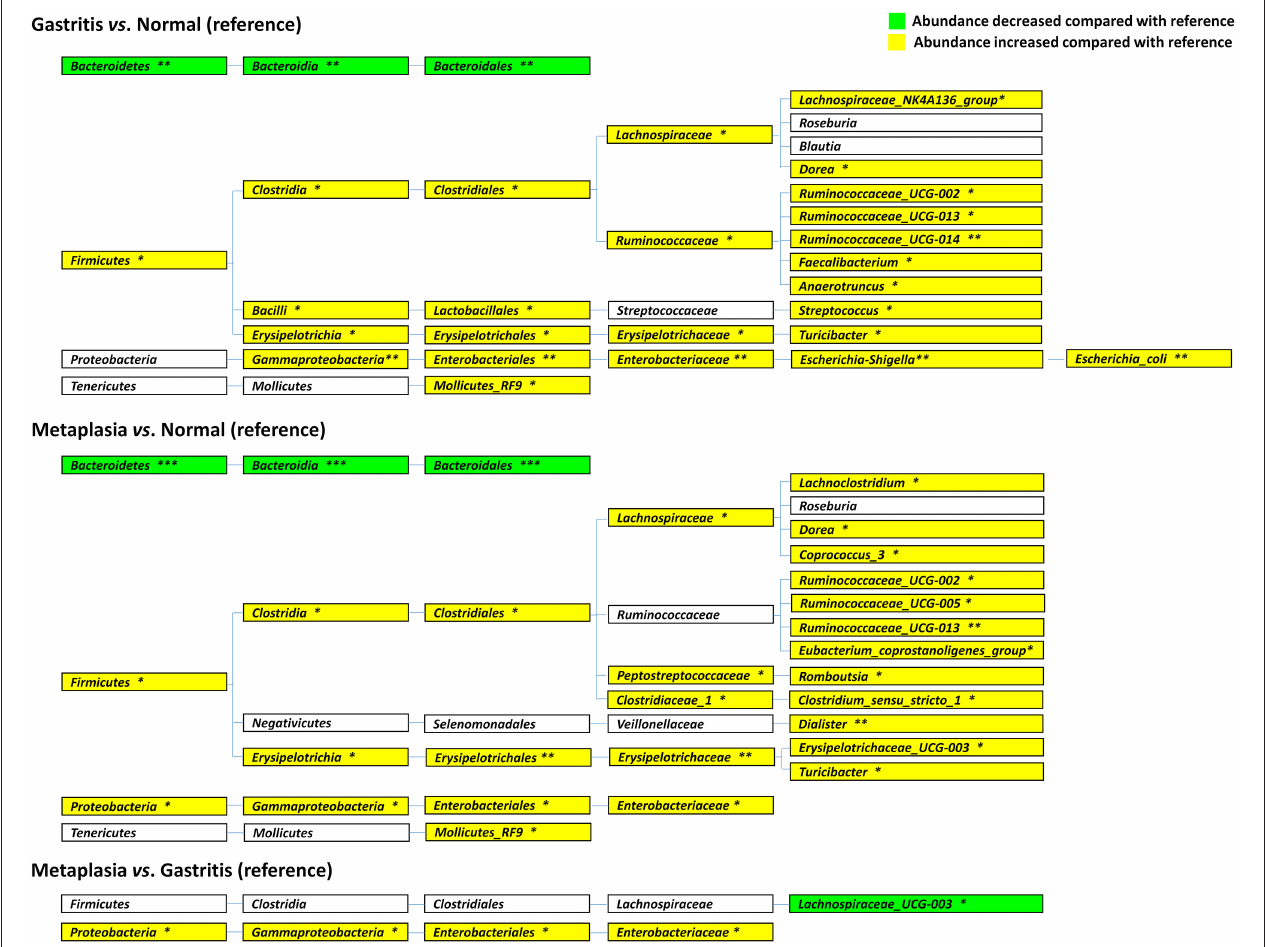
FIGURE 4 | Cladogram of differentially distributed taxa among different gastric lesion groups. The differential taxa are illustrated between gastritis and normal, metaplasia and normal, or metaplasia and gastritis groups as * p < 0.05, ** p < 0.01, and *** p < 0.001,